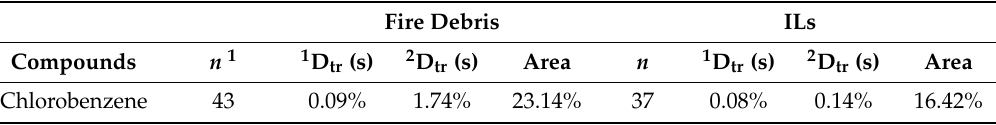
Table 3. RSD values calculated for the internal standard for fire debris samples and intact ILs.